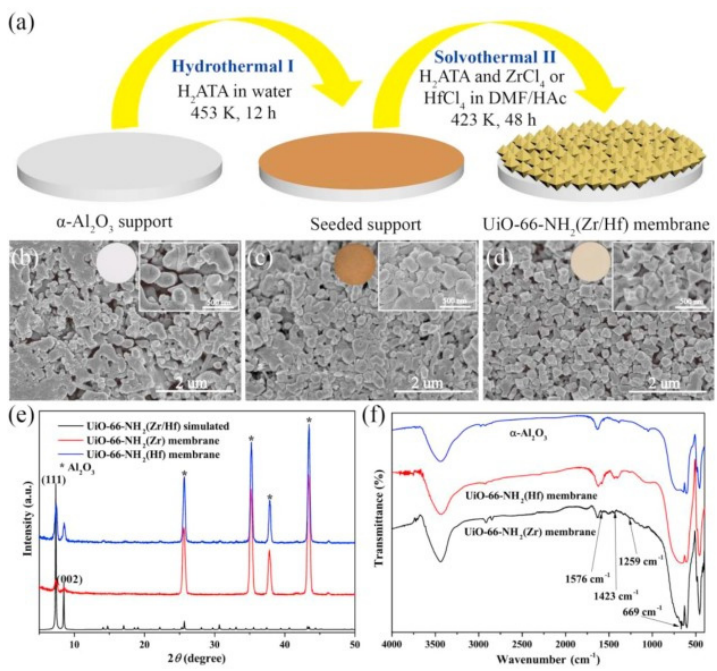
Figure 4. ( a ) Schematic diagram of UiO-66-NH 2 (Zr / Hf) membrane preparation procedure. SEM images of the ( b ) α -Al 2 O 3 support, ( c ) seed layer, and ( d ) UiO-66-NH 2 (Zr) membrane surface. ( e ) XRD patterns of UiO-66-NH 2 (Zr / Hf) membrane. ( f ) FTIR spectra of UiO-66-NH 2 (Zr / Hf) membrane. Reprinted with permission from [63], Copyright (2019) Elsevier.